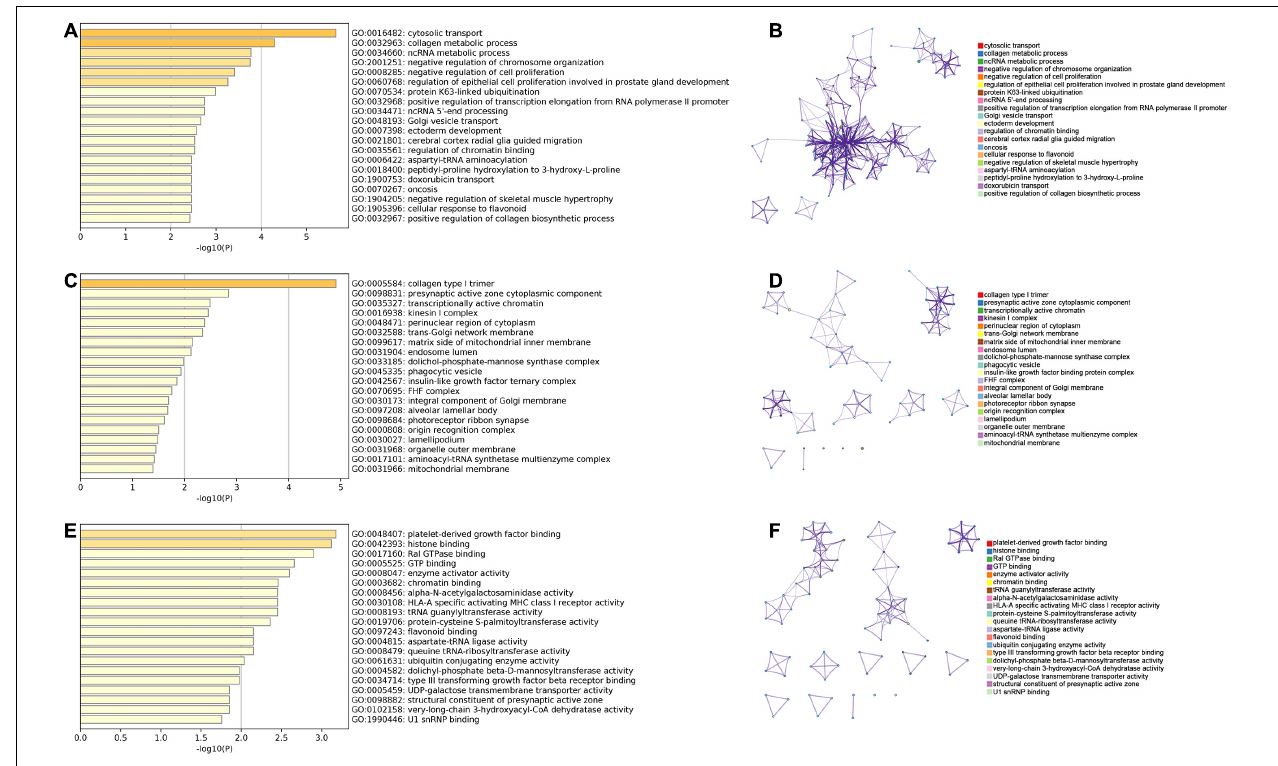
FIGURE 1 | GO analysis of parent genes for prognostic APA events. (A,B) The result of biological process of in the GO analysis. (C,D) The result of cellular component of in the GO analysis. (E,F) The result of molecular function of in the GO analysis. GO, Gene Ontology; APA, alternative polyadenylation.